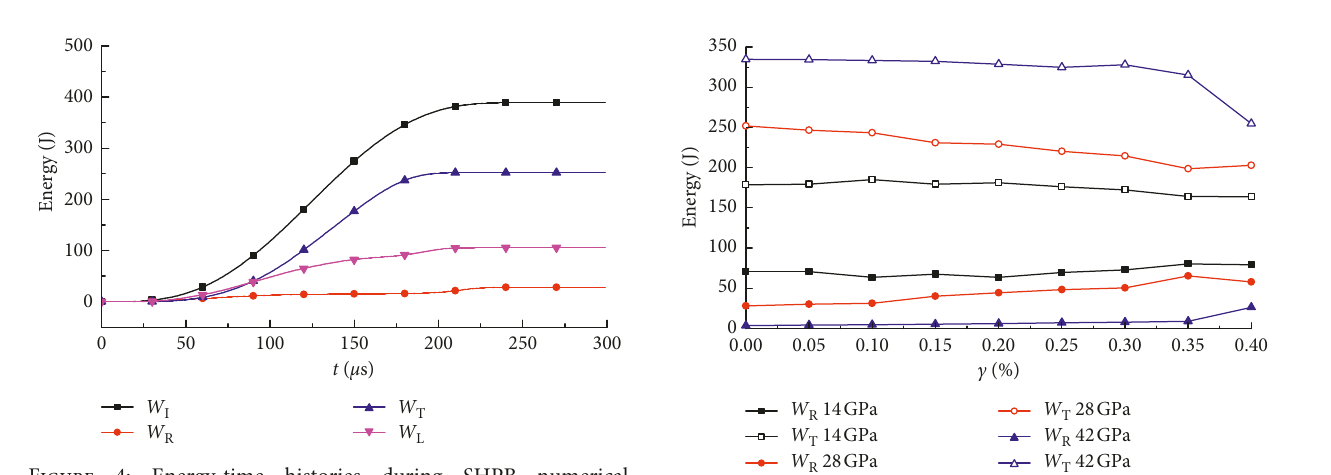
Figure 4: Energy-time histories during SHPB numerical